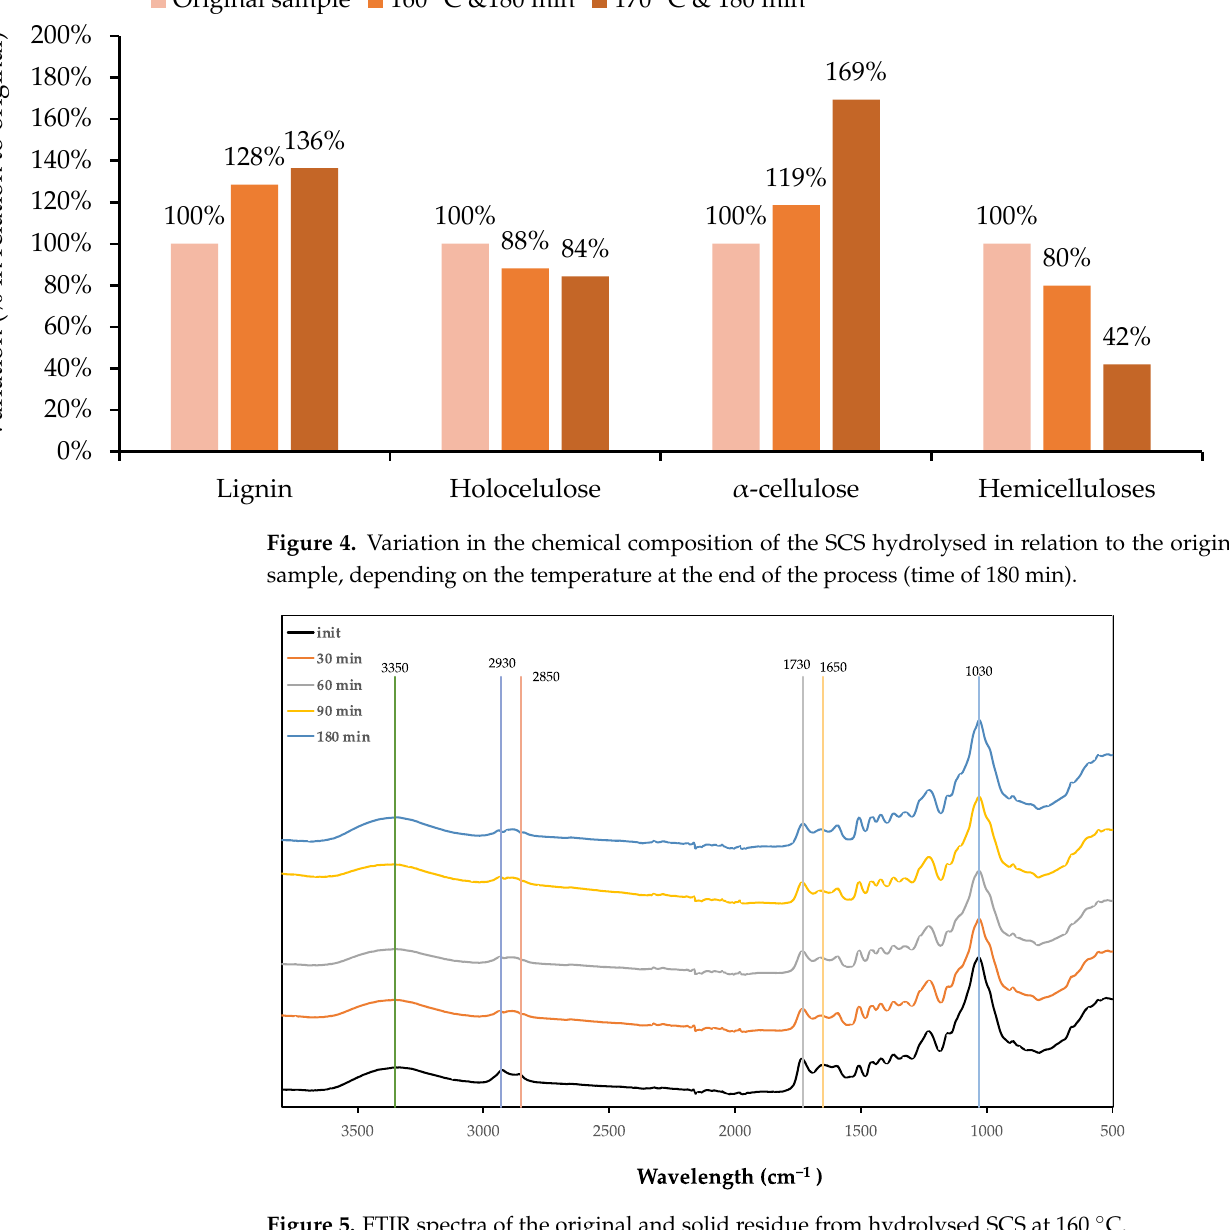
Figure 5. FTIR spectra of the original and solid residue from hydrolysed SCS at 160 °C.